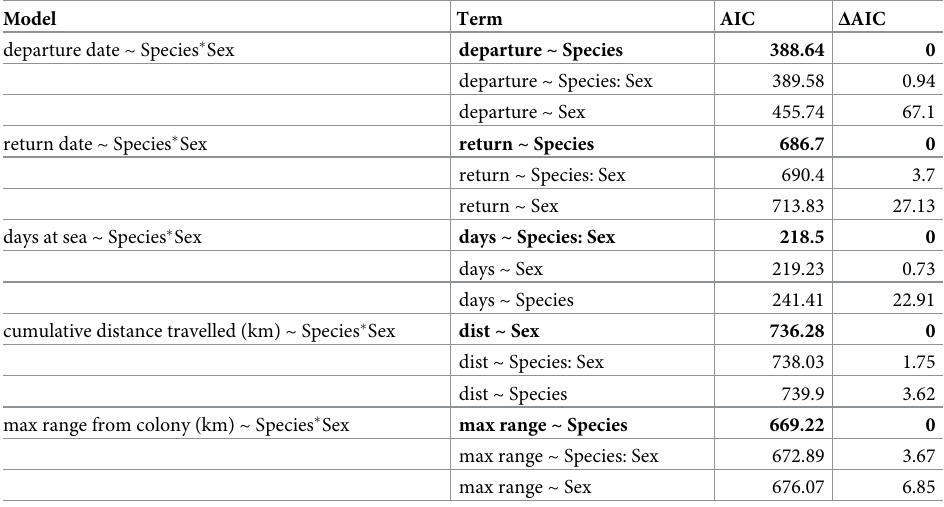
Table 2. Backwards elimination step-wise models of differences for trip characteristics between Fiordland pen- guins and Snares penguins tracked during the post-moult dispersal period. Model